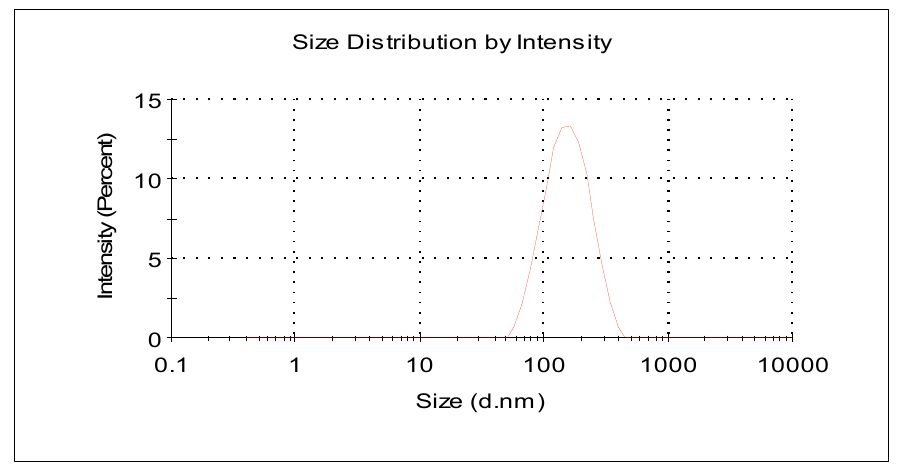
Figure 1. Particle size and size distribution of nanoparticles examined by DLS. A nanochitin sample, with a concentration of 0.0024% w / v , was prepared by diluting a stock of nanochitin suspension with DI water, then 1 mL of the dilution was examined by NanoSizer, ZS 90, and the pH of the dilution was not adjusted. The polydispersity index (PDI) was 0.246.